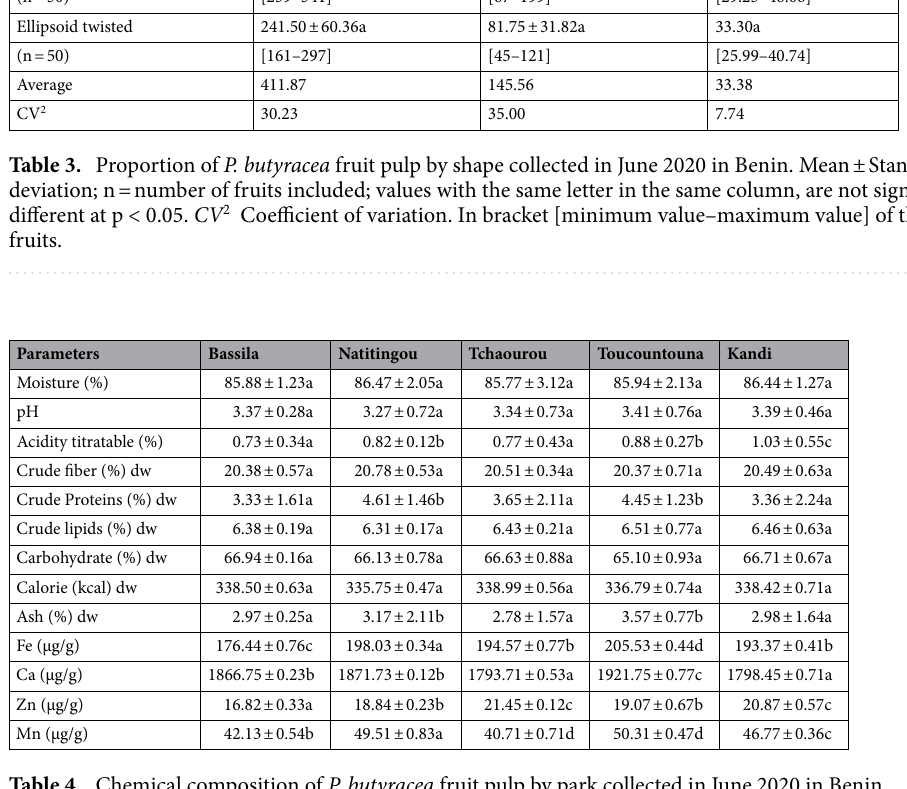
Table 4. Chemical composition of P. butyracea fruit pulp by park collected in June 2020 in Benin. Mean ± Standard deviation; values with the same letter in the same line, are not significantly different at p <